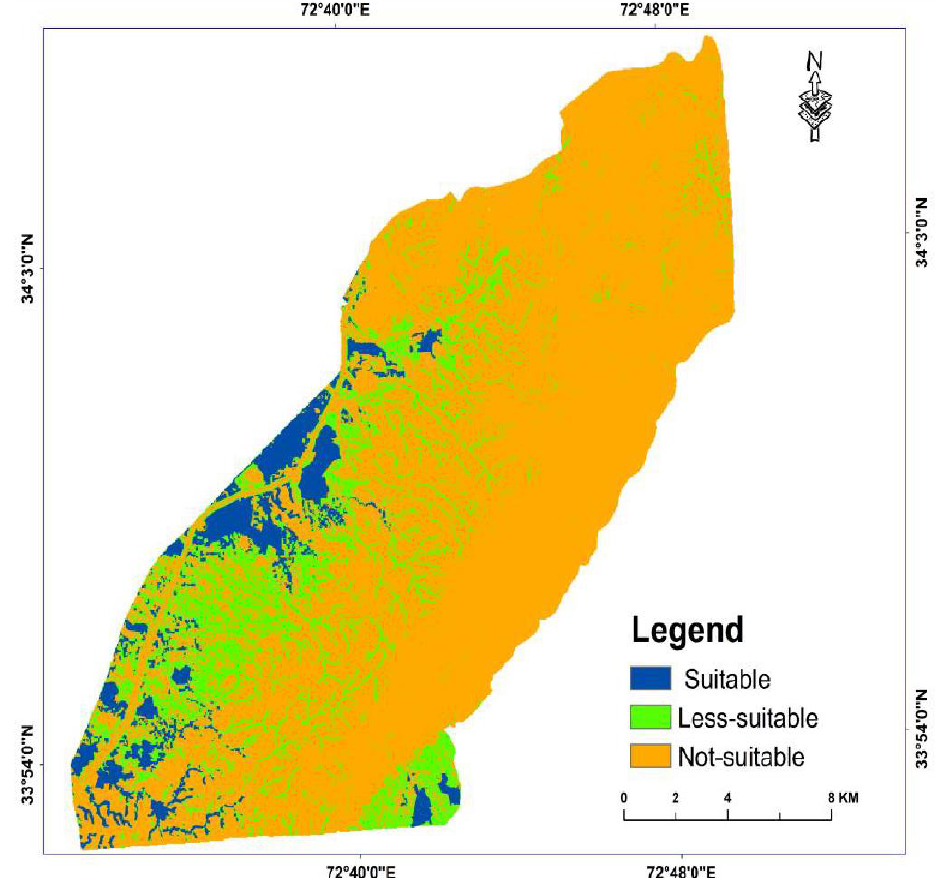
Figure 10. Categories of suitability for farm ponds.